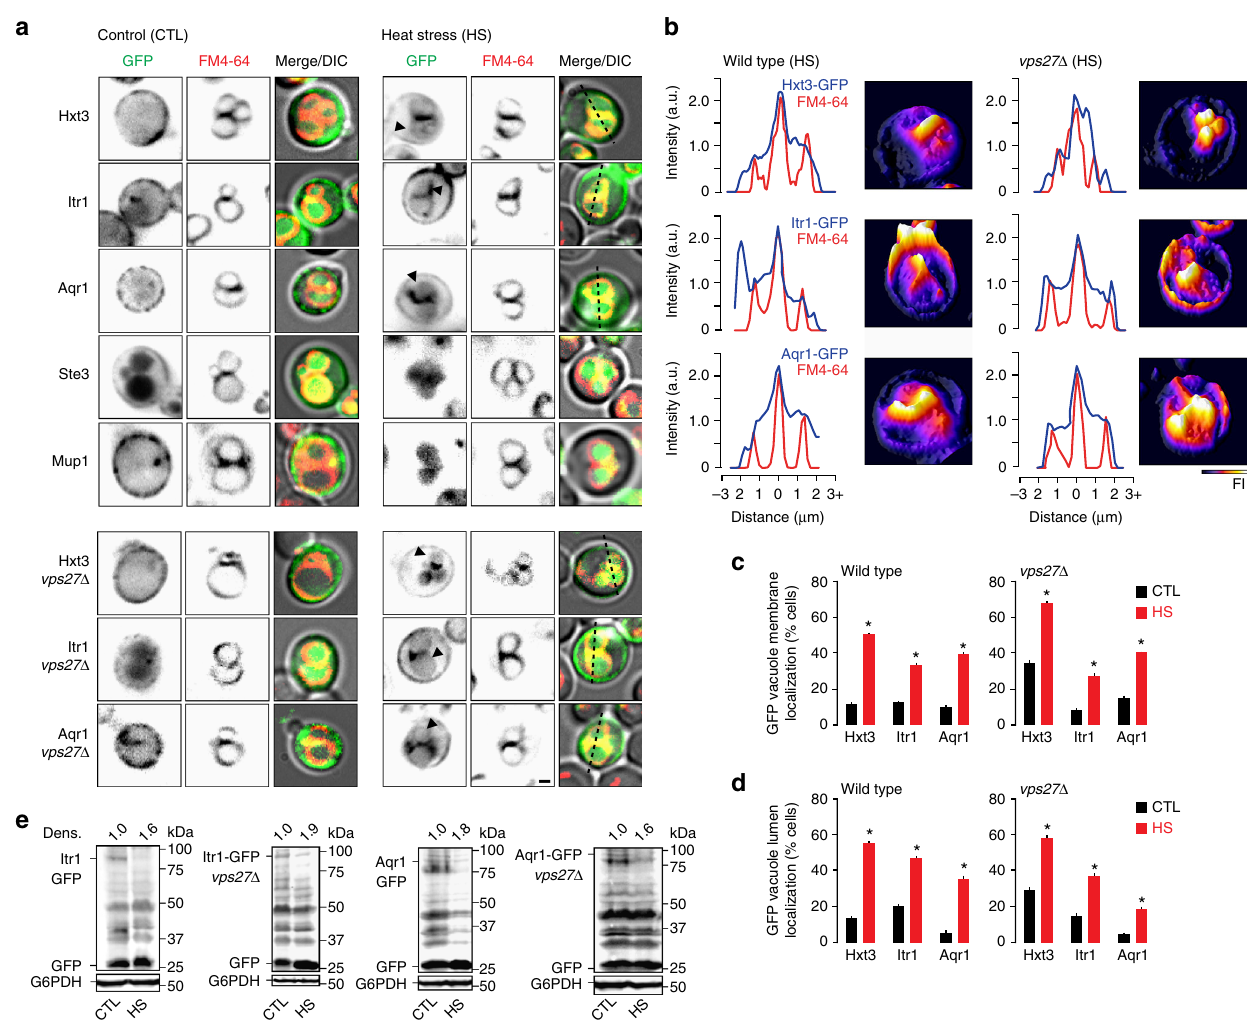
Fig. 7 Quality control of surface transporters Itr1 and Aqr1 is mediated by the ILF pathway. a Fluorescence and DIC micrographs of live wild type (top) and vps27 Δ (bottom) cells expressing GFP-tagged Hxt3, Itr1, Aqr1, Ste3, or Mup1 before (control) and after heat stress (37 °C for 15 min). Vacuole membranes were stained with FM4 – 64. Arrowheads indicate GFP on the vacuole membrane. Scale bar, 1 µ m. b Three-dimensional GFP fl uorescence intensity (FI) plots and line plots (left) of GFP or FM4 – 64 fl uorescence intensity for lines shown in a to indicate boundary membrane localization after heat stress. c , d Using micrographic data shown in a , we measured the proportion of wild type or vps27 Δ cells with GFP fl uorescence observed on the vacuole membrane ( c ) or within the lumen ( d ) before (CTL) or after heat stress. Averages ± S.E.M. are shown. * P < 0.05, as compared to CTL by t -test. n = 4 experiments whereby a total of 238 Hxt3-GFP cells, 180 Itr1-GFP cells, 180 Aqr1-GFP cells were analyzed under CTL conditions, and 222 Hxt3-GFP cells, 161 Itr1-GFP, 167 Aqr1-GFP cells were analyzed after HS. e Western blot analysis of whole-cell lysates prepared from wild type or vps27 Δ cells expressing Itr1-GFP or Aqr1-GFP before (CTL) or after heat stress (HS) stained with anti-GFP antibody. Estimated molecular weights and cleaved GFP band densities (Dens.) relative to CTL normalized to load controls (G6PDH) are shown. Blots are representatives of n = 3